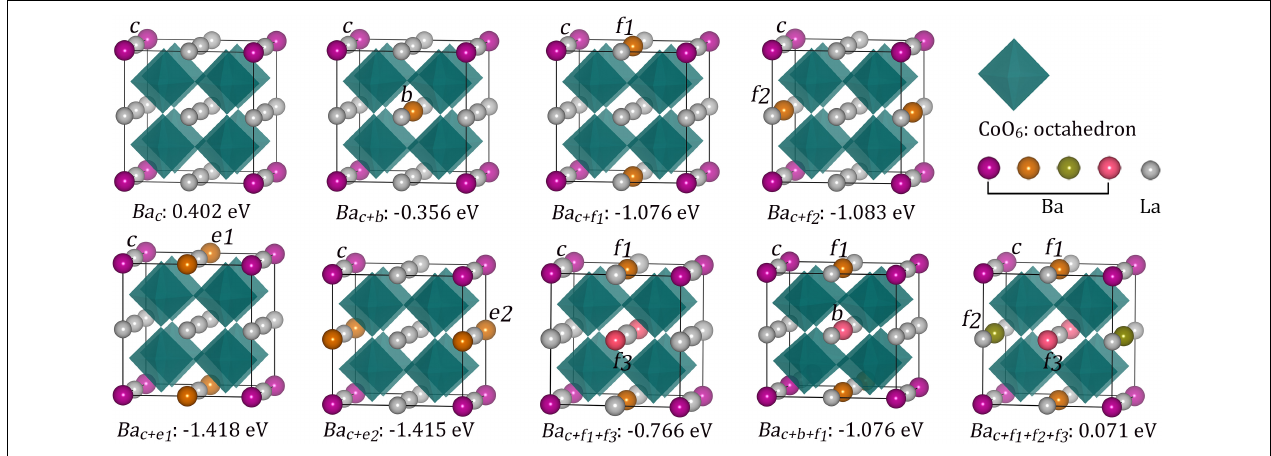
FIGURE 5 | Optimized structures of Ba-substituted LaCoO 3 and corresponding stabilization energies of Ba substitutional defects.